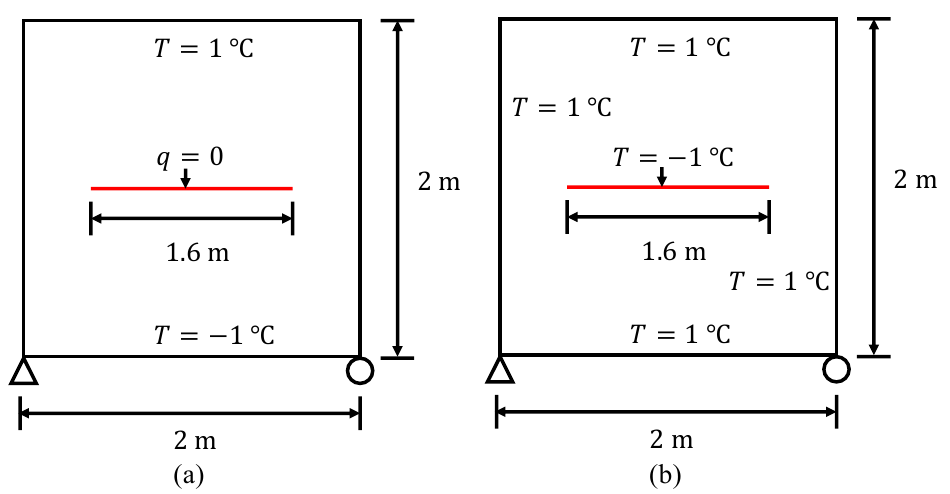
Figure 3. Geometry and boundary conditions of a square plate with a horizontal center crack: ( a ) adiabatic case; ( b ) isothermal case.